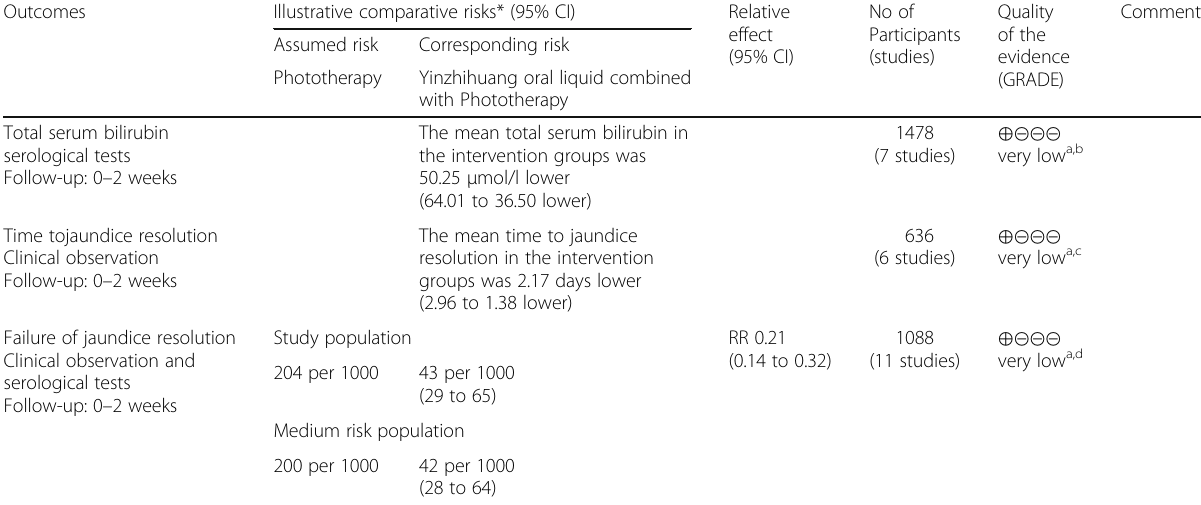
Table 2 Summary of findings ’ table